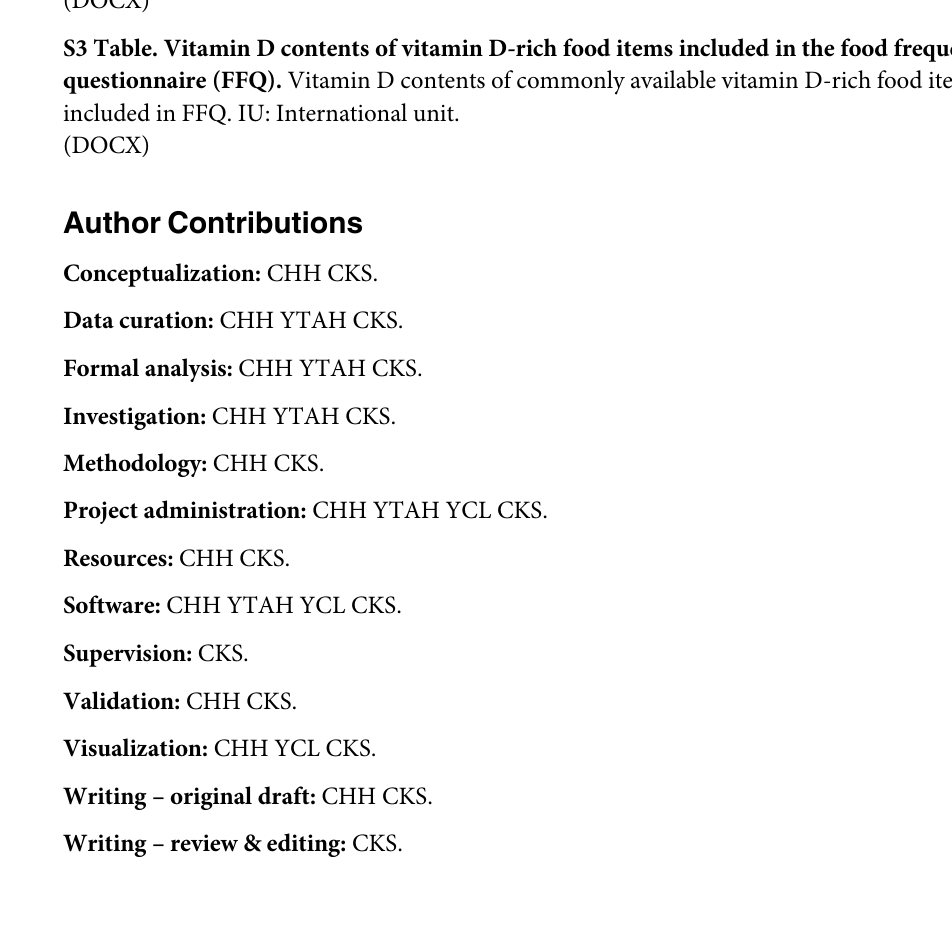
S1 Table. Food frequency questionnaire (FFQ). English version of FFQ estimating oral vita- min D intake through assessing the frequency of vitamin D-rich food consumption in recent 3 months. S2 Table. Food frequency questionnaire (FFQ). Original Chinese version of FFQ estimating oral vitamin D intake through assessing the frequency of vitamin D-rich food consumption in